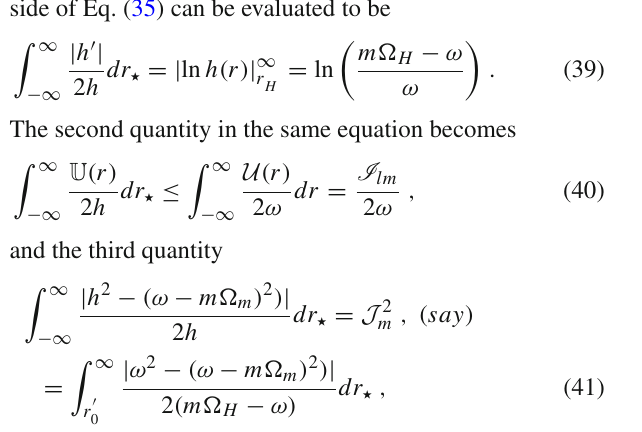
different angular momentum quantum number m becomes irrelevant in the calculation of the bound on the greybody factor. Then one can consider the expressions provided for m = 0 in Eq. (26) with Eq. (27) for the evaluation of these